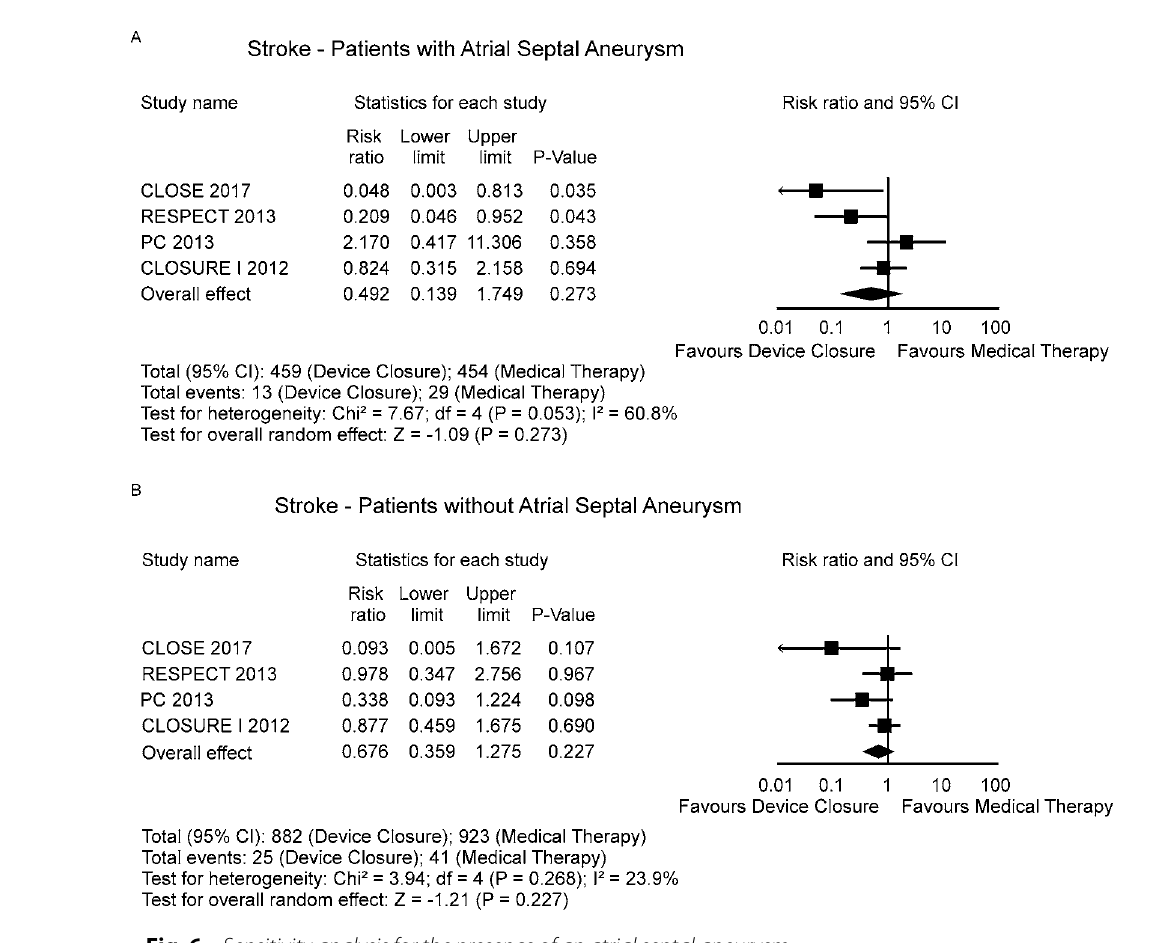
Fig. 6 – Sensitivity analysis for the presence of an atrial septal